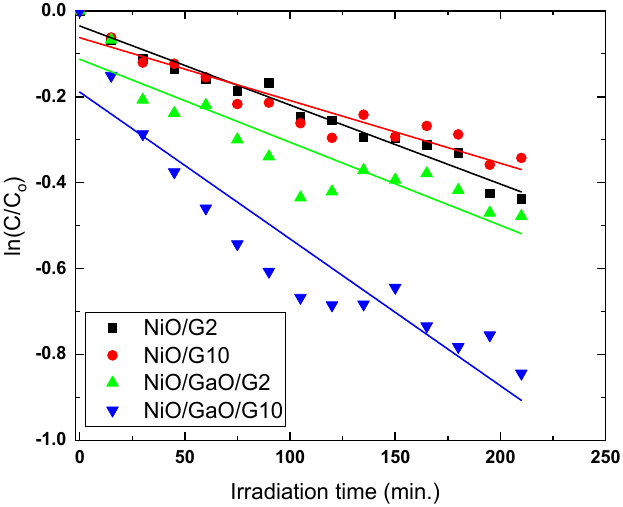
Table 4. The absolute values of first-order reaction rate constants (k) and the degradation equilib- rium constant (K), experimental q e values for the 20 mg/L CR degradation at 303 K. Figure 8. Semi-logarithmic graph of CR concentration vs. irradiation time in the presence of NiO/G2, NiO/G10, NiO/Ga 2 O 2 /G2, and NiO/Ga 2 O 2 /G10 nanocomposites.